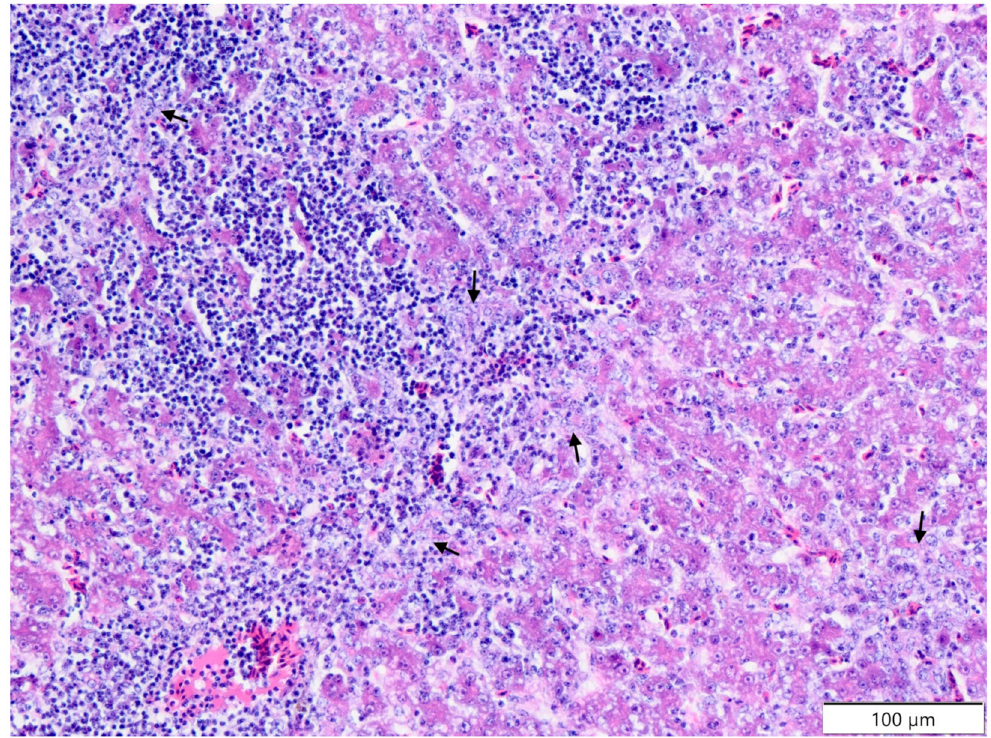
Figure 3. Japanese quail. Liver. CP group. 12th day of experiment. Infiltration of lymphoid cells; proliferation of bile ductules (black arrows). Haematoxylin and eosin